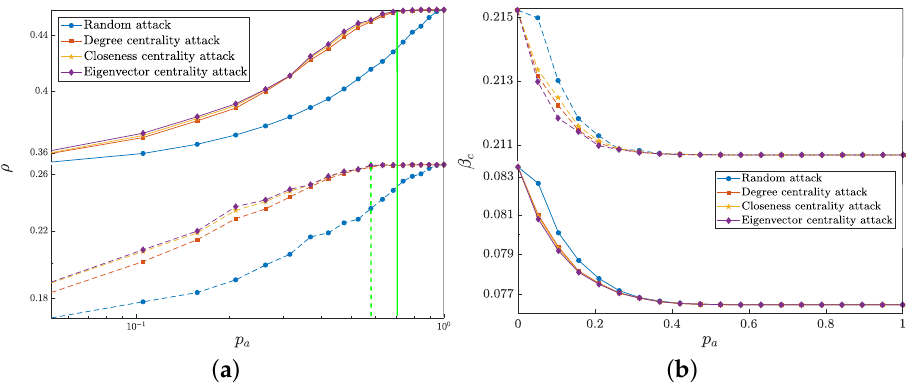
Figure 9. The I-state density ρ ( a ) and the threshold β c ( b ) with respective to the attacked node proportion p a under four attack strategies. The solid and dashed lines represent the variation of the group-based multilayer network and the multiplex network, respectively, where the lines in the same color represent the same attack strategy. Other parameters are fixed as γ = 0.1, λ 1 = η = µ = 0.9, β = τ = δ = λ 2 = 0.5, ι = 1.1, and ¯ x = ¯ y =